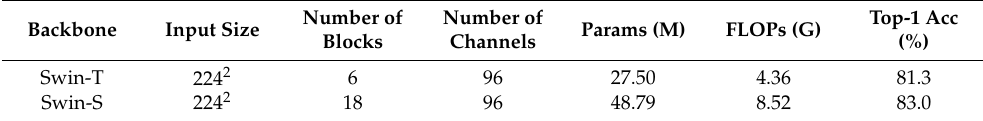
Table 1. Swin transformer backbone specifications.